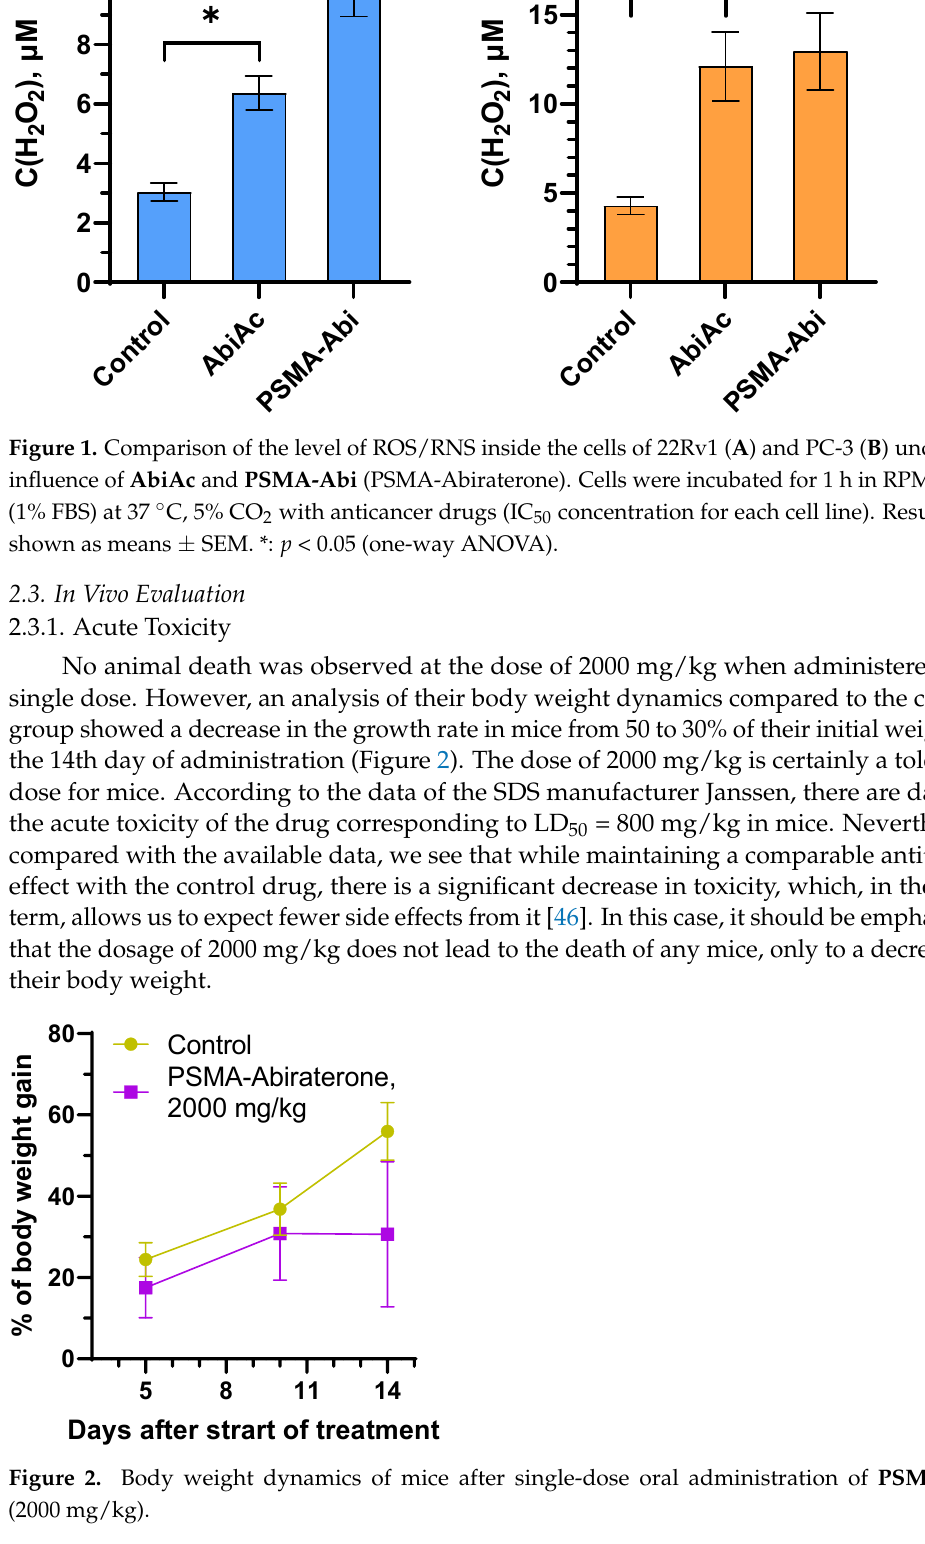
ns ✱ Figure 3. Growth dynamics of subcutaneous 22Rv1 prostate cancer xenografts under the effect of 14-fold oral administration of PSMA-Abi at a single concentration of 500 mg/kg/day (7.0 g/kg total) and AbiAc at 200 mg/kg/day (2.8 g/kg total).